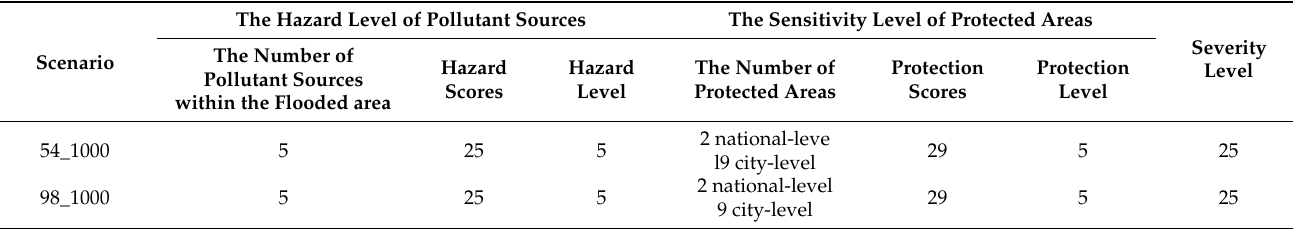
Table 7. The assessment results of environmental